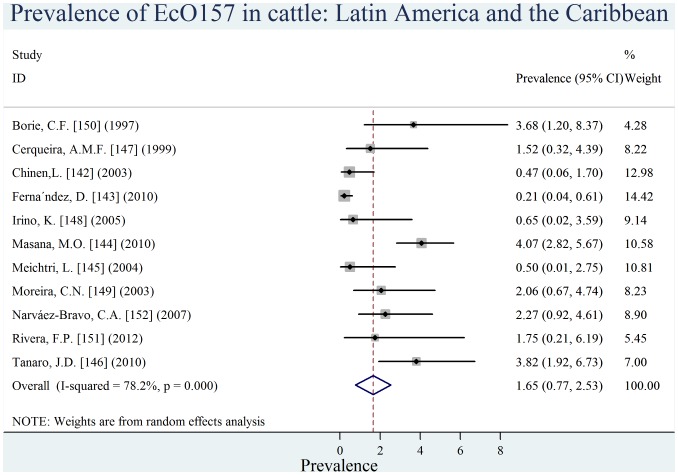
Forest plot of prevalence of E. coli O157 in cattle amongst studies conducted in Latin America and Caribbean.